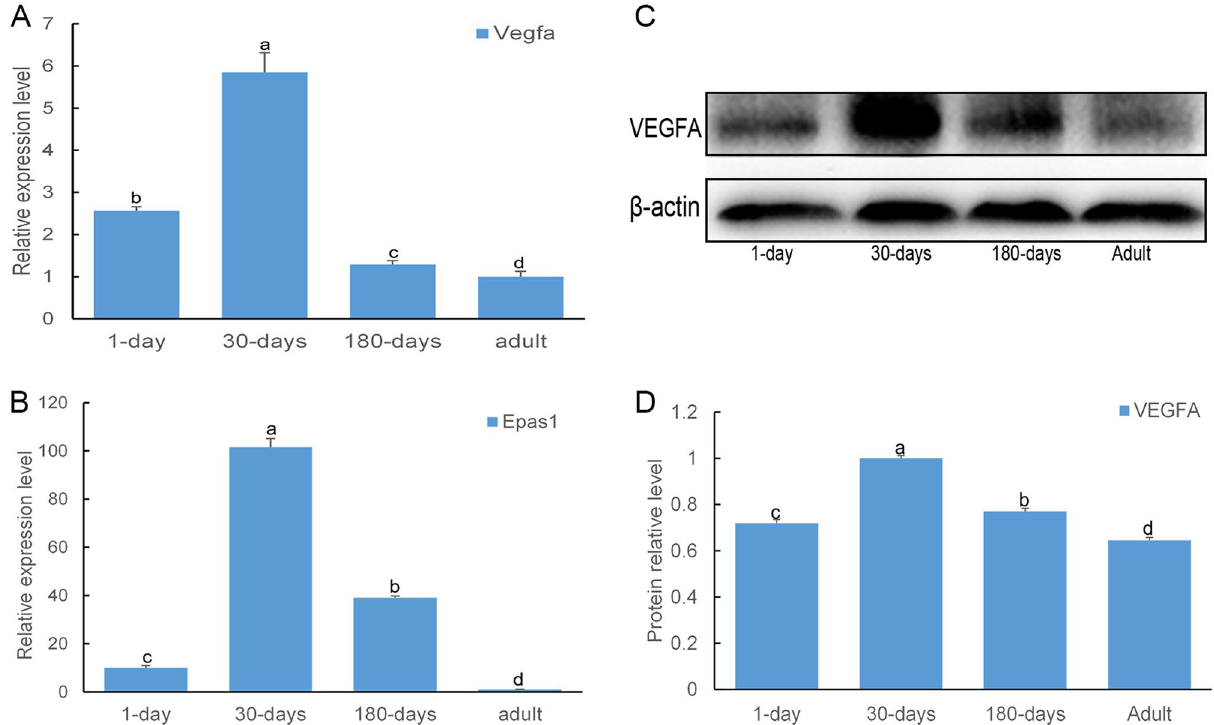
Figure 4. Relative expression levels of VEGFA and EPAS1 in the plateau yak lung tissues at different developmental stages (1 day, 30 days, 180 days, adult). ( A ) Relative VEGFA mRNA levels in the lungs of plateau yaks at different developmental stages. ( B ) Relative EPAS1 mRNA levels in the lungs of plateau yaks at different developmental stages. ( C ) VEGFA protein expression at different developmental stages as determined by western blot analysis. ( D ) The graph represents a densitometric analysis of VEGFA protein expression. (Full- length blots are presented in Supplementary Figures S1 and S2). VEGFA protein content is expressed as relative levels and was quantified using ImagePro Plus software. VEGFA protein expression levels were normalized to β-Actin protein levels. All values above represent the mean ± SD (n = 3). Different letters (a, b, c, and d) indicate significant differences ( P <